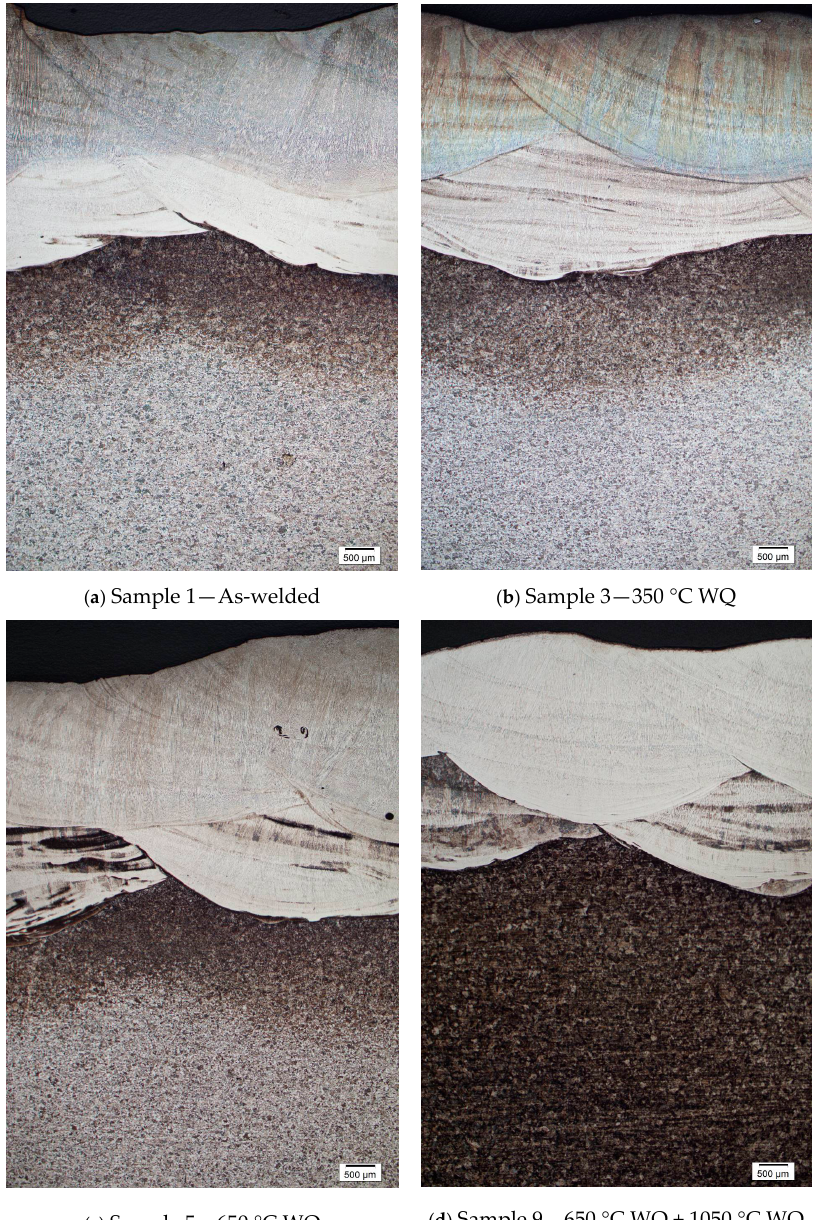
Figure 6. SEM image of heat a ff ected zone (HAZ) for weld metal and their dilution